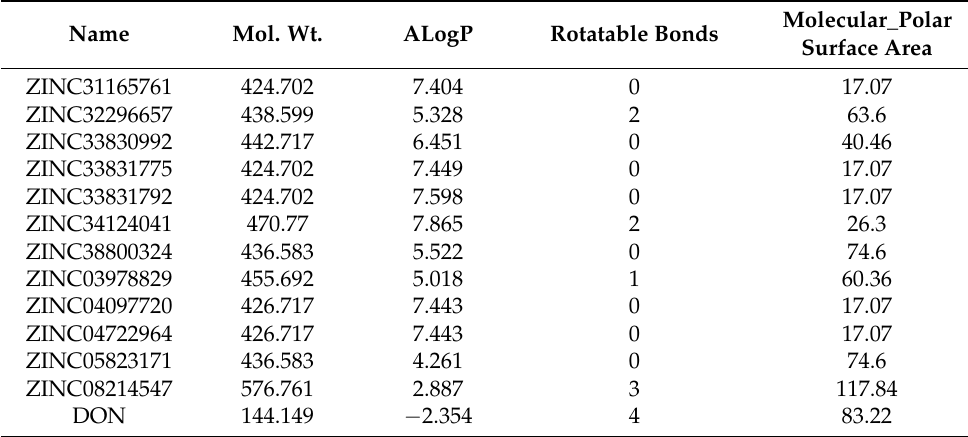
Table 2. List of compounds filtered by Lipinski and Veber